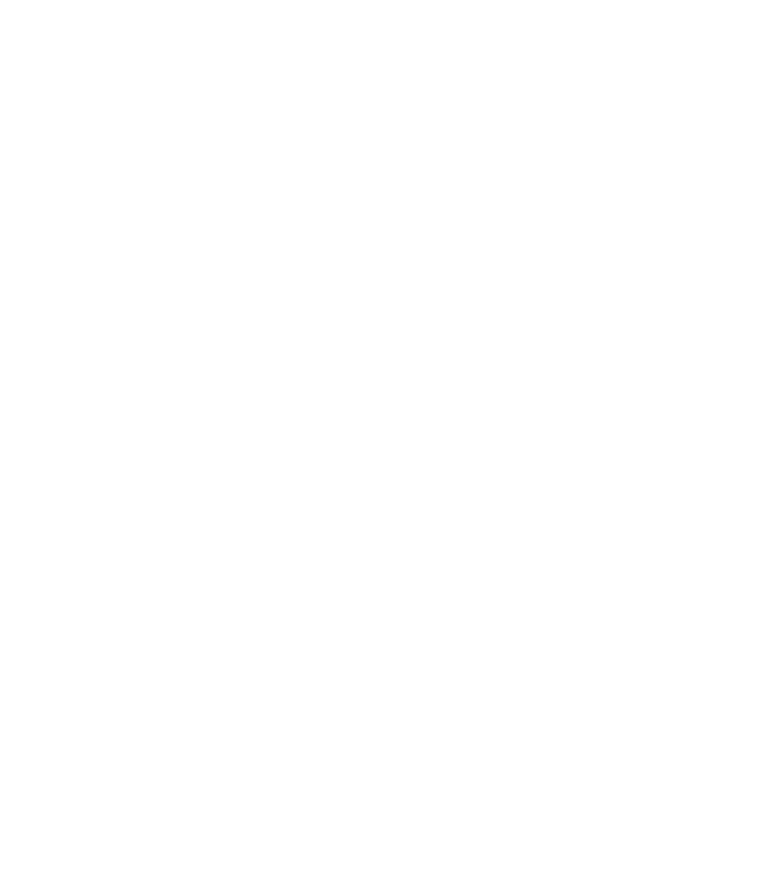
Screenshots of the OCaPPI-Db web interface.